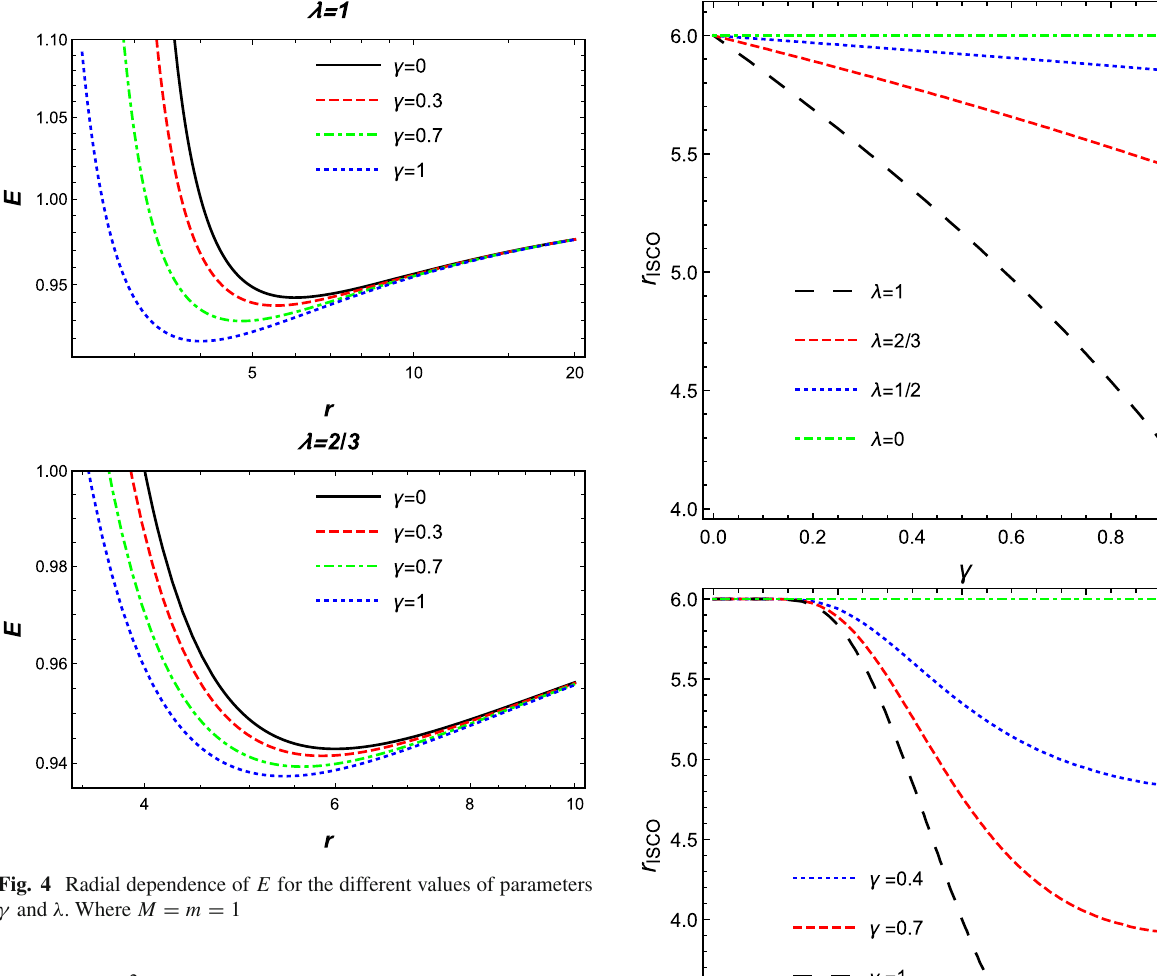
on parameters γ and λ in KR ISCO